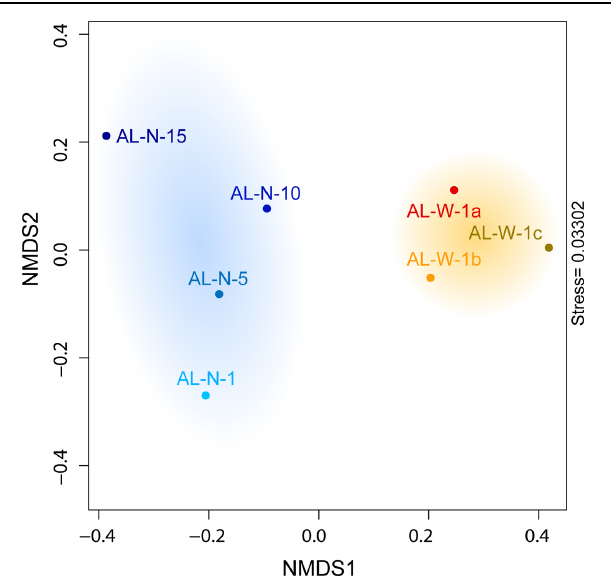
FIGURE 5 | Non-Metric Multi-dimensional Scaling (NMDS) plot showing differences in microbial community composition between all seven samples for both eukaryotes and prokaryotes.